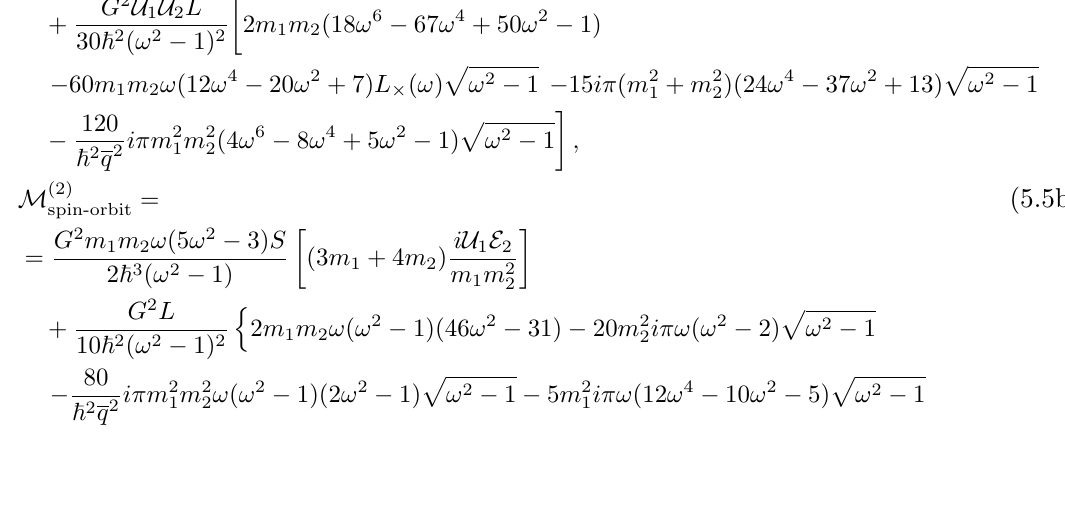
Figure 2. The one-loop Feynman diagrams containing non-analytic pieces that contribute to the classical scattering of two particles in GR. Solid lines represent fermions, wavy lines represent gravitons, and dashed lines represent the ghost (cid:12)eld arising from working in the harmonic gauge [15].